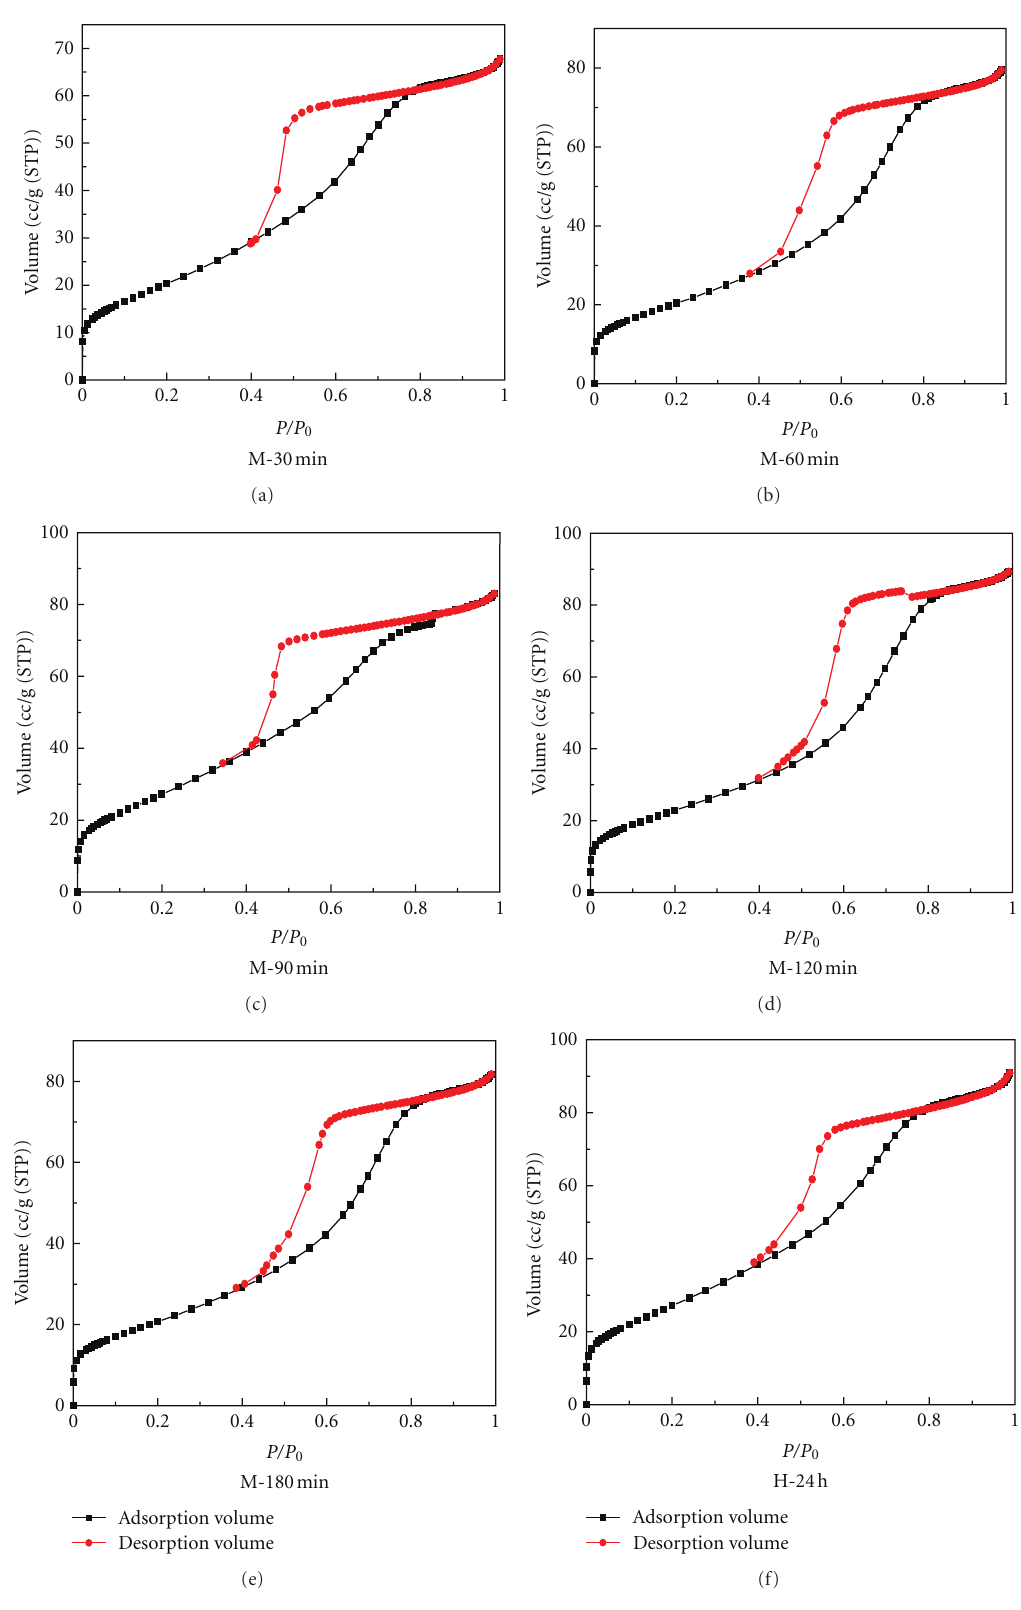
Figure 2: N 2 adsorption and desorption isotherm for CeO 2 -SiO 2 samples prepared by di ff erent irradiation times and hydrothermal